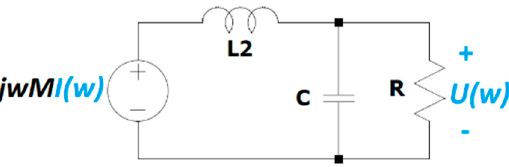
Figure 6. Equivalent circuit in the Laplace domain of the secondary coil of the magnetically coupled sensor.